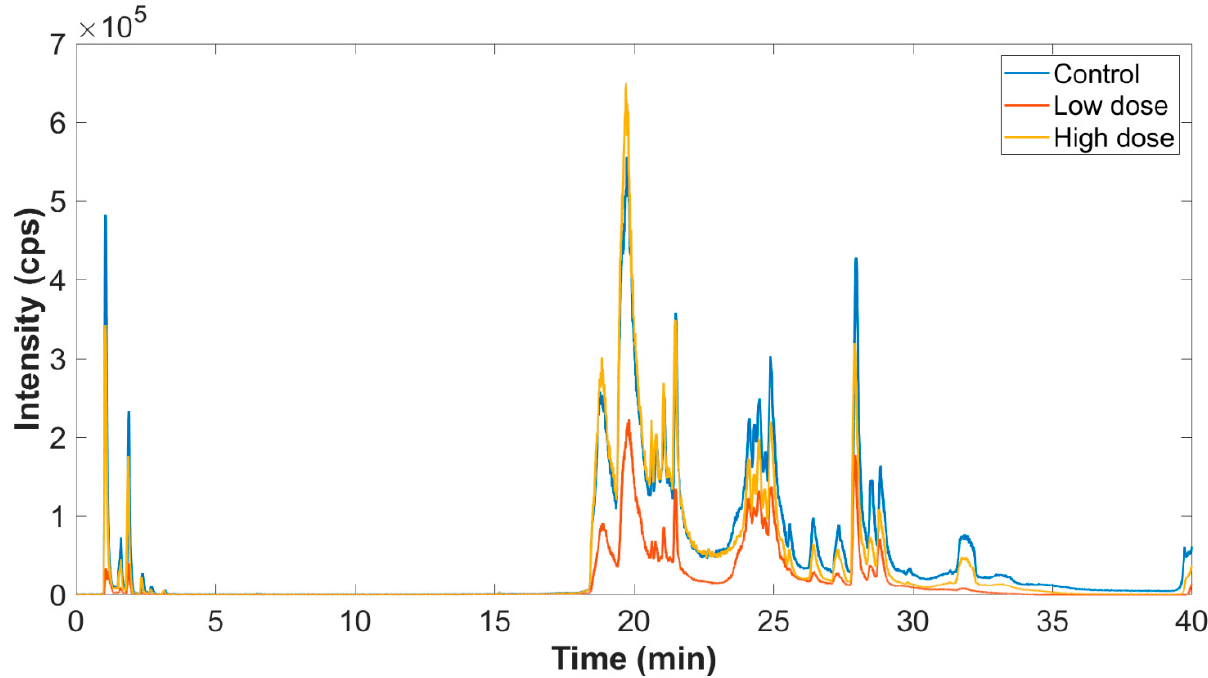
Figure 3. A total ion chromatogram (TIC) of metabolites extracted from the mouse liver tissue exposed to PS-MPs.